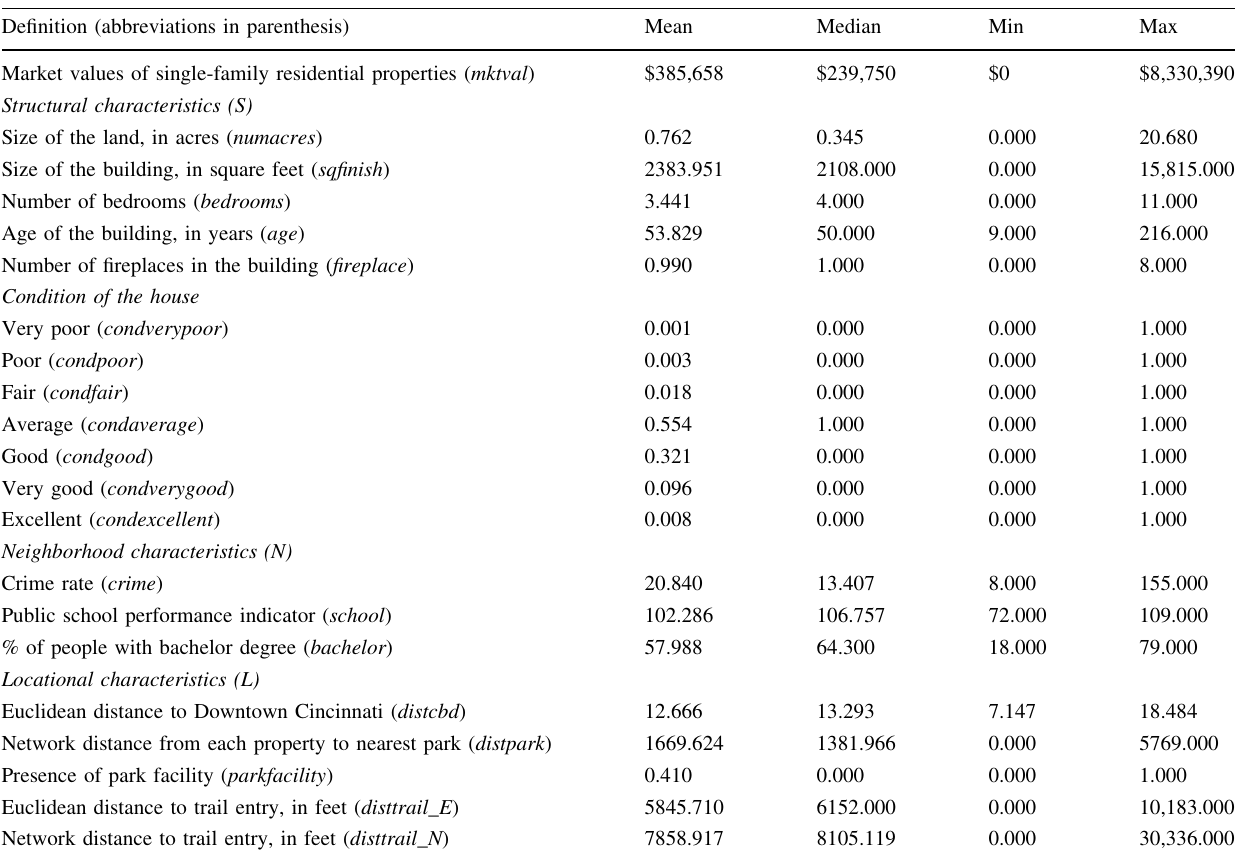
Table 1 Variables: definitions and summary statistics ( n = 8822) Definition (abbreviations in